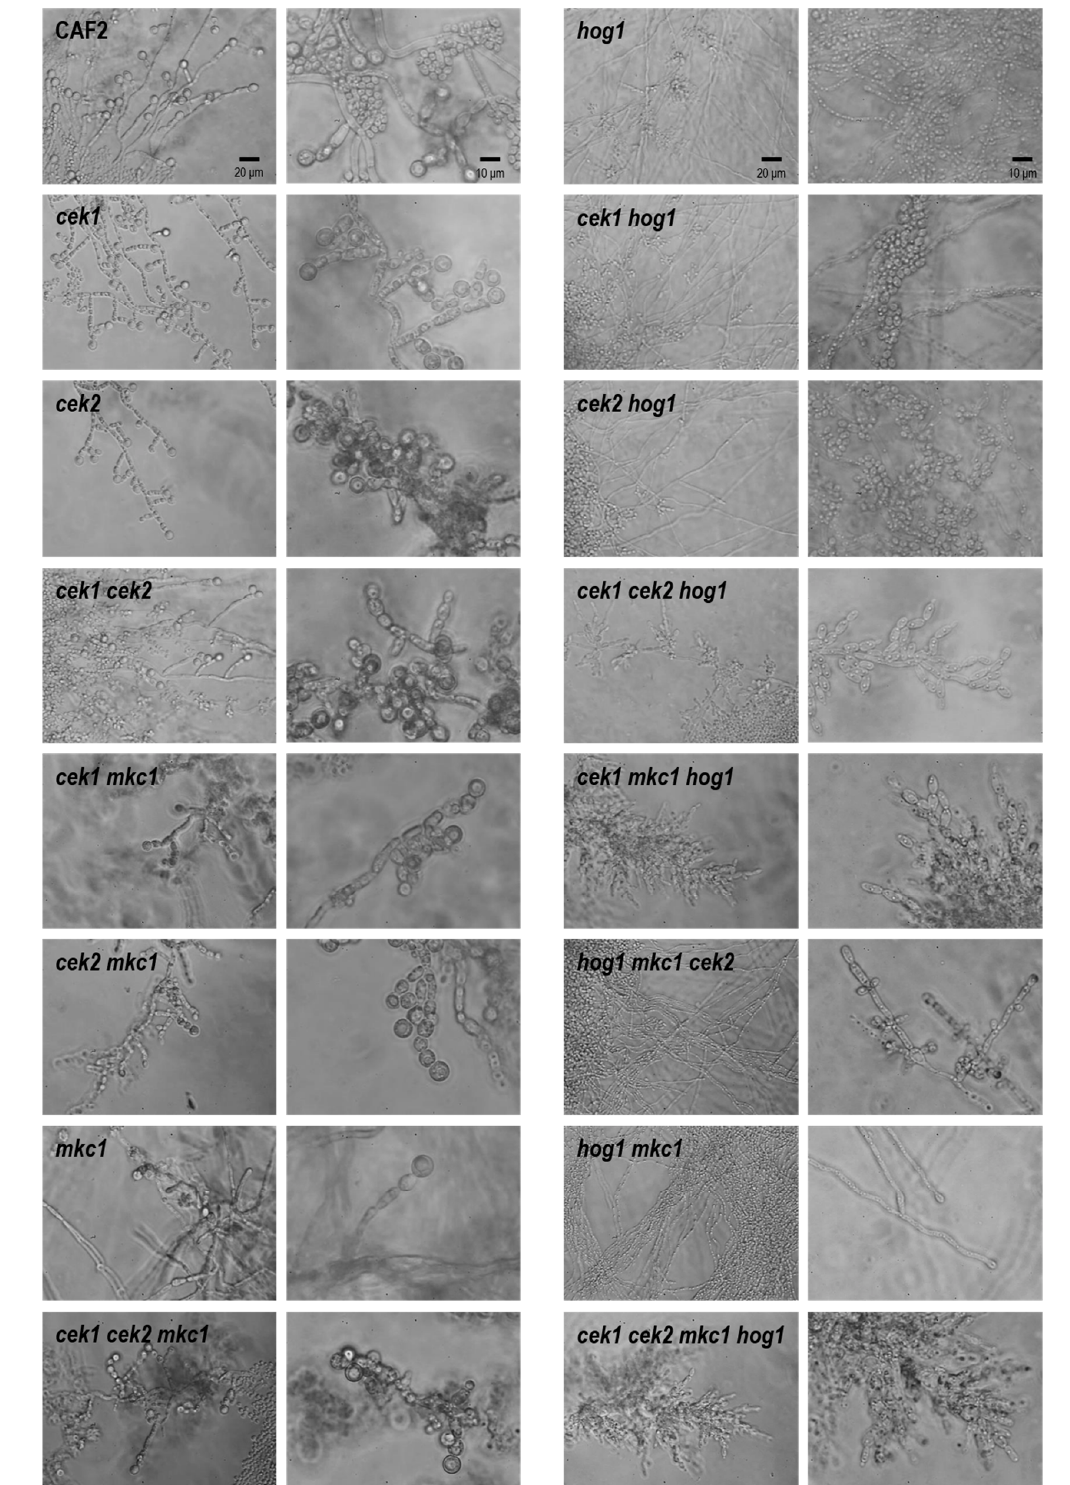
Figure 6. Twenty-five to fifty cells from stationary grown cultures were inoculated on Corn Meal Agar medium supplemented with Tween 80. Chlamydospores were observed between 4 and 7 days upon incubation at 24 °C in dark and microaerophilic conditions. Representative pictures are shown. Pictures in the same column were taken at the same magnification. Scale bar is shown in the first row. Neither Cek1, Cek2 nor Mkc1 is necessary for the formation of these structures. In fact, cek2 and cek1 cek2 seem to present clusters of cells that could derive from an increased number of